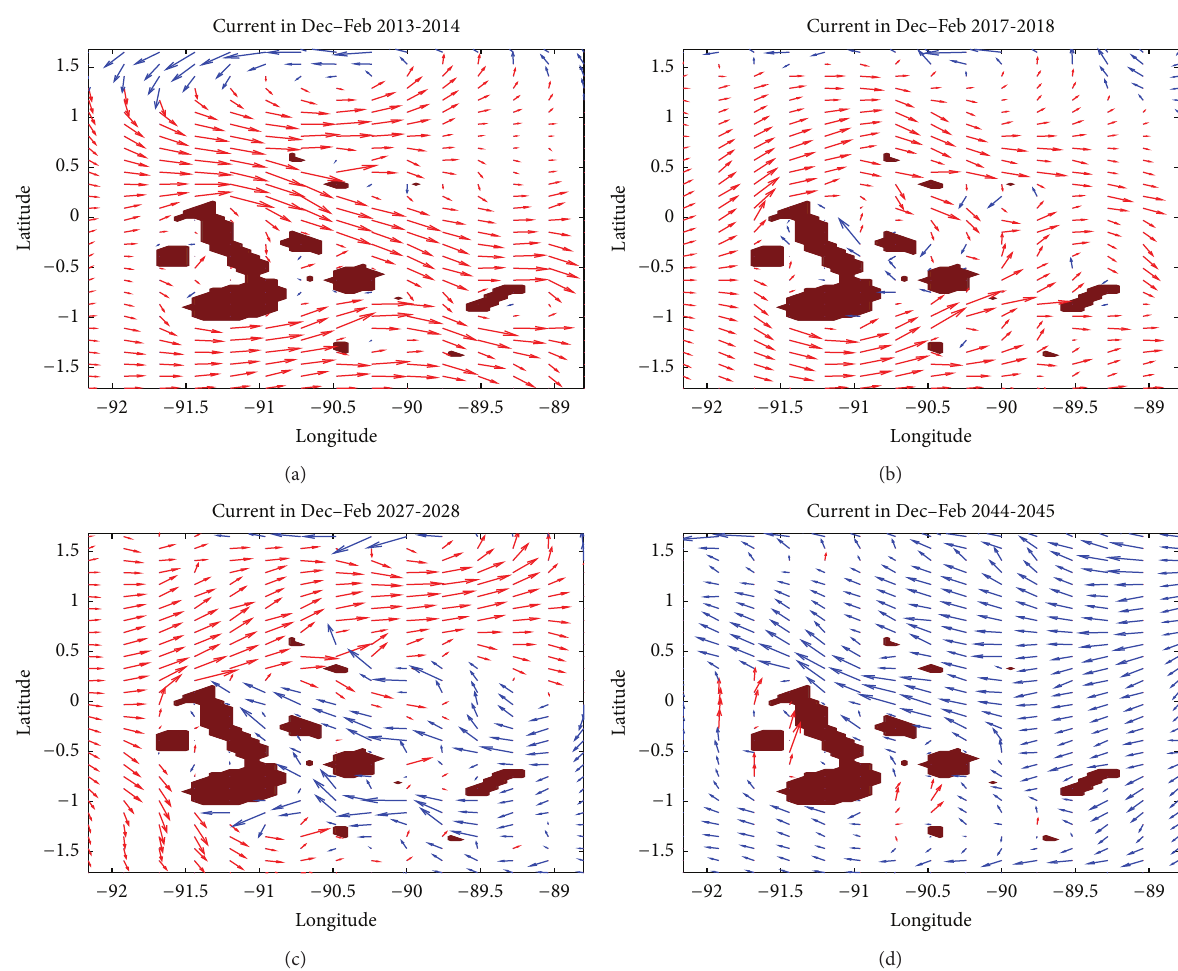
Figure 13: The current at 40m around the GMR during the El Ni˜no cases: (a) in Dec–Feb in 2013-2014, (b) in Dec–Feb in 2017-2018, (c) in Dec–Feb in 2027-2028, and (d) in Dec–Feb in